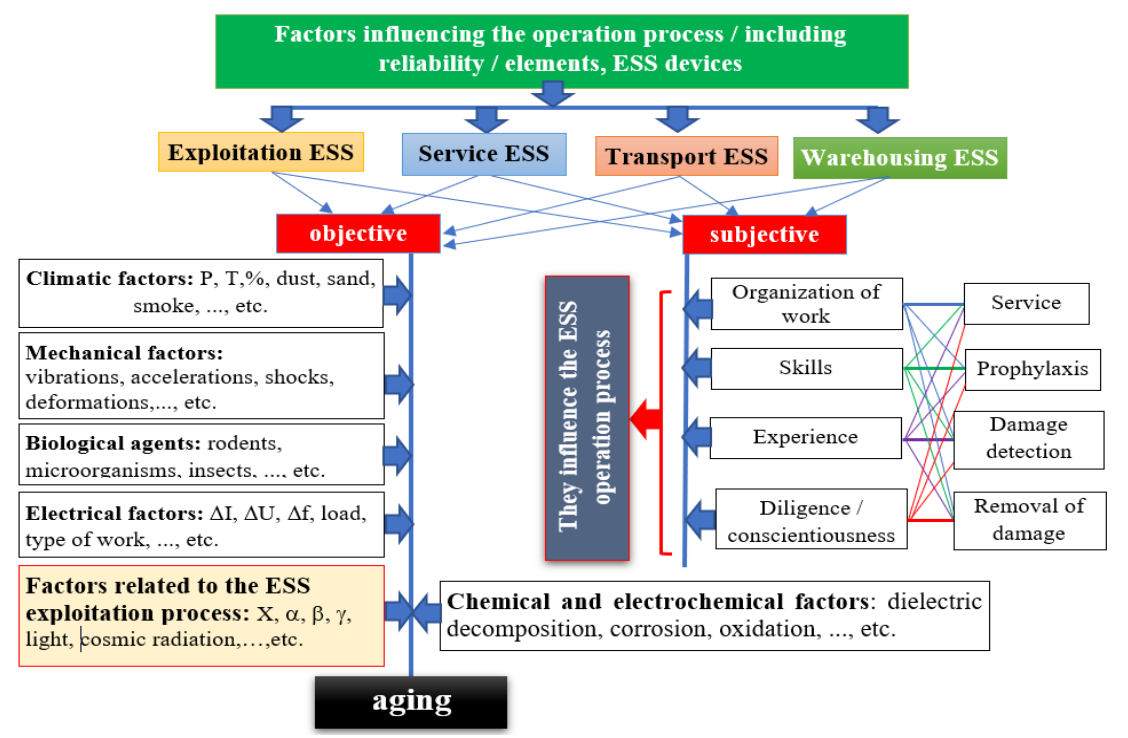
Figure 4. Impact of selected passive and active factors on the FAS operation process [72,73].